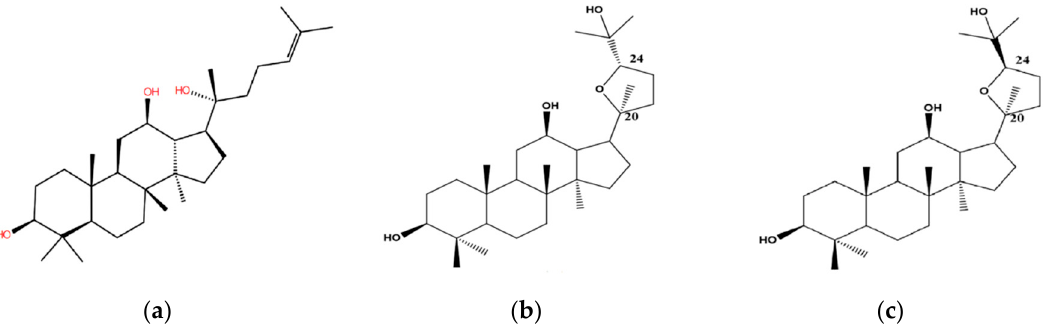
Figure 1. Chemical structure of ( a ) 20 S -PPD; ( b ) 24 S -PDQ; ( c ) 24 R -PDQ.